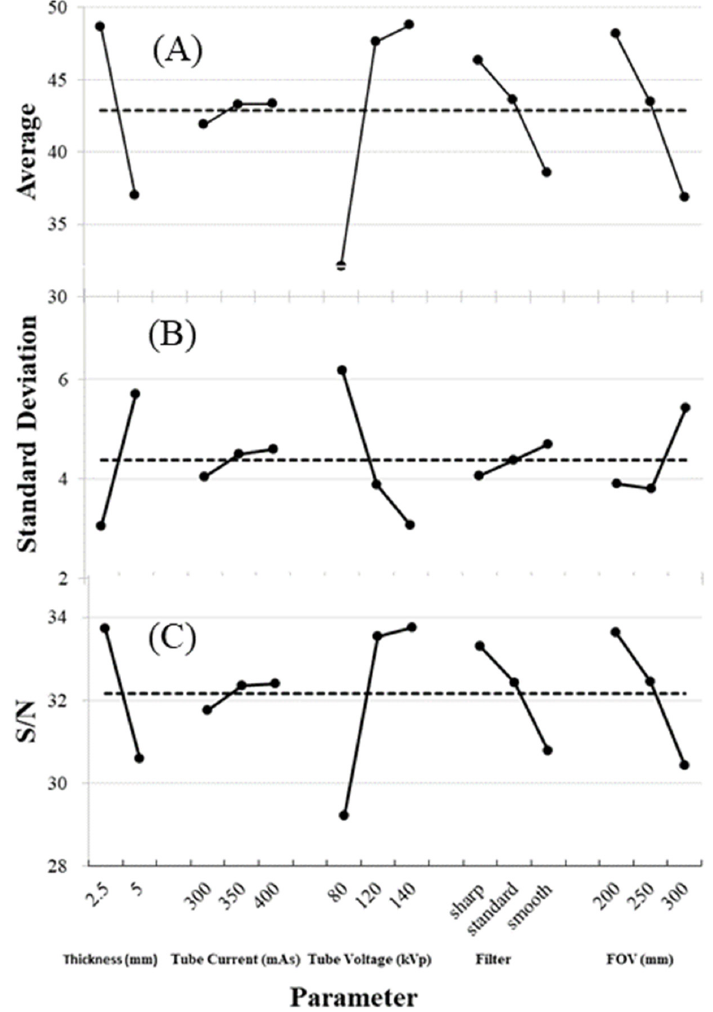
Figure 3. Fish ‐ bone ‐ plots of ( A ) the average grades, ( B ) the standard deviations of the grades and ( C ) S/N value against the parameters in the 128 ‐ slice brain CT experiments. A1 (2.5 mm thickness), B3 (400 mAs), C3 (140 kVp), D1 (sharp filter), and E1 (200 mm 2 ) yield the highest S/N among the 18 experiments.